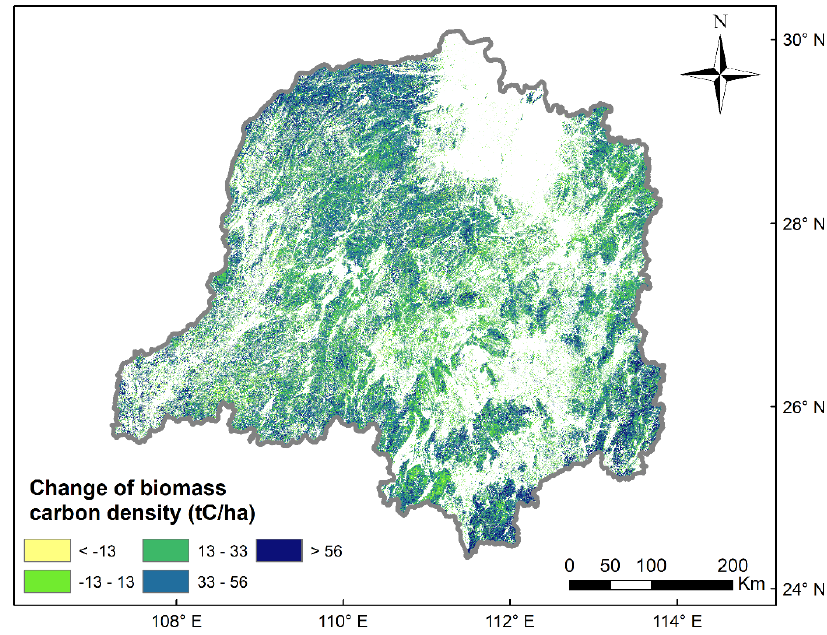
Figure 4. Biomass carbon density change of forest and shrub.